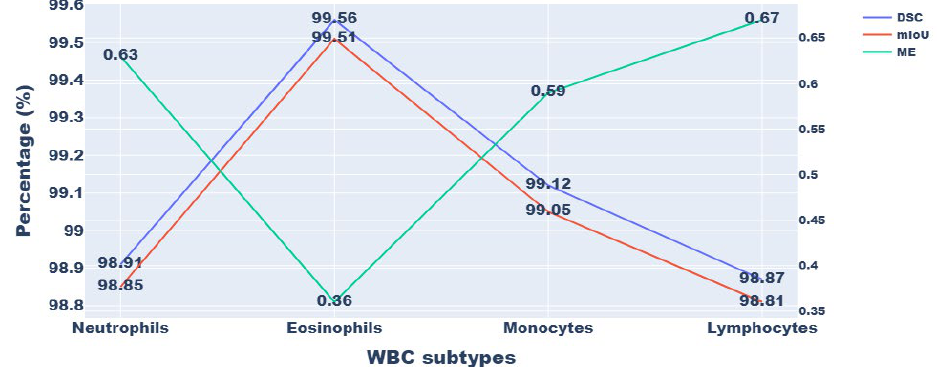
Figure 3. Segmentation results on the BCCD dataset.